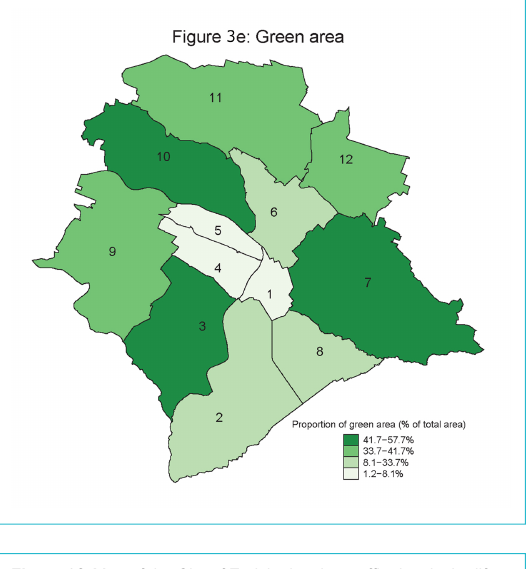
Figure 3f: Map of the City of Zurich showing traffic density in dif- ferent districts (intensity of the colour symbolises the quantity of proportion; dark = high proportion, light = low proportion) (n = 7145).